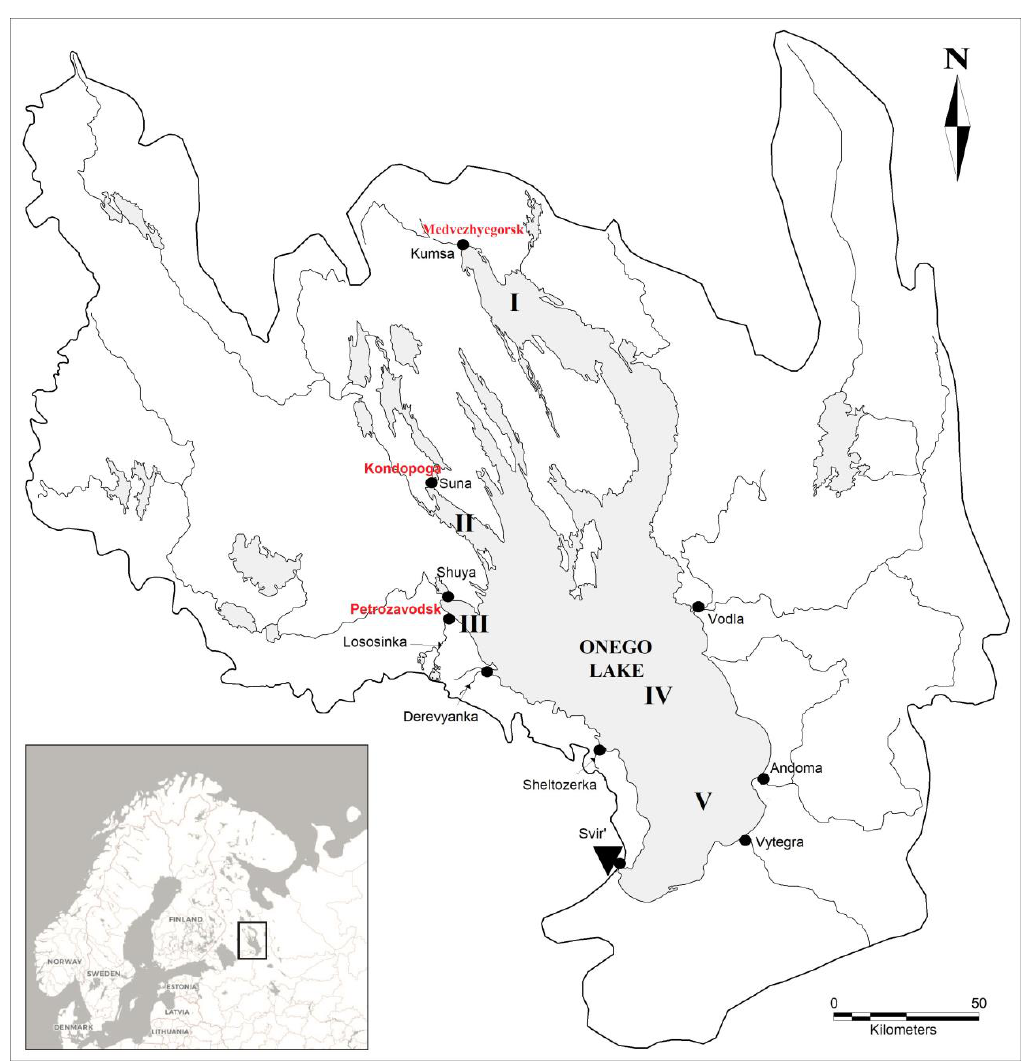
Figure 1. Study area: I—Gulf of Povenets; II—Kondopoga Bay; III—Petrozavodsk Bay; IV—Central Onego; V—Southern